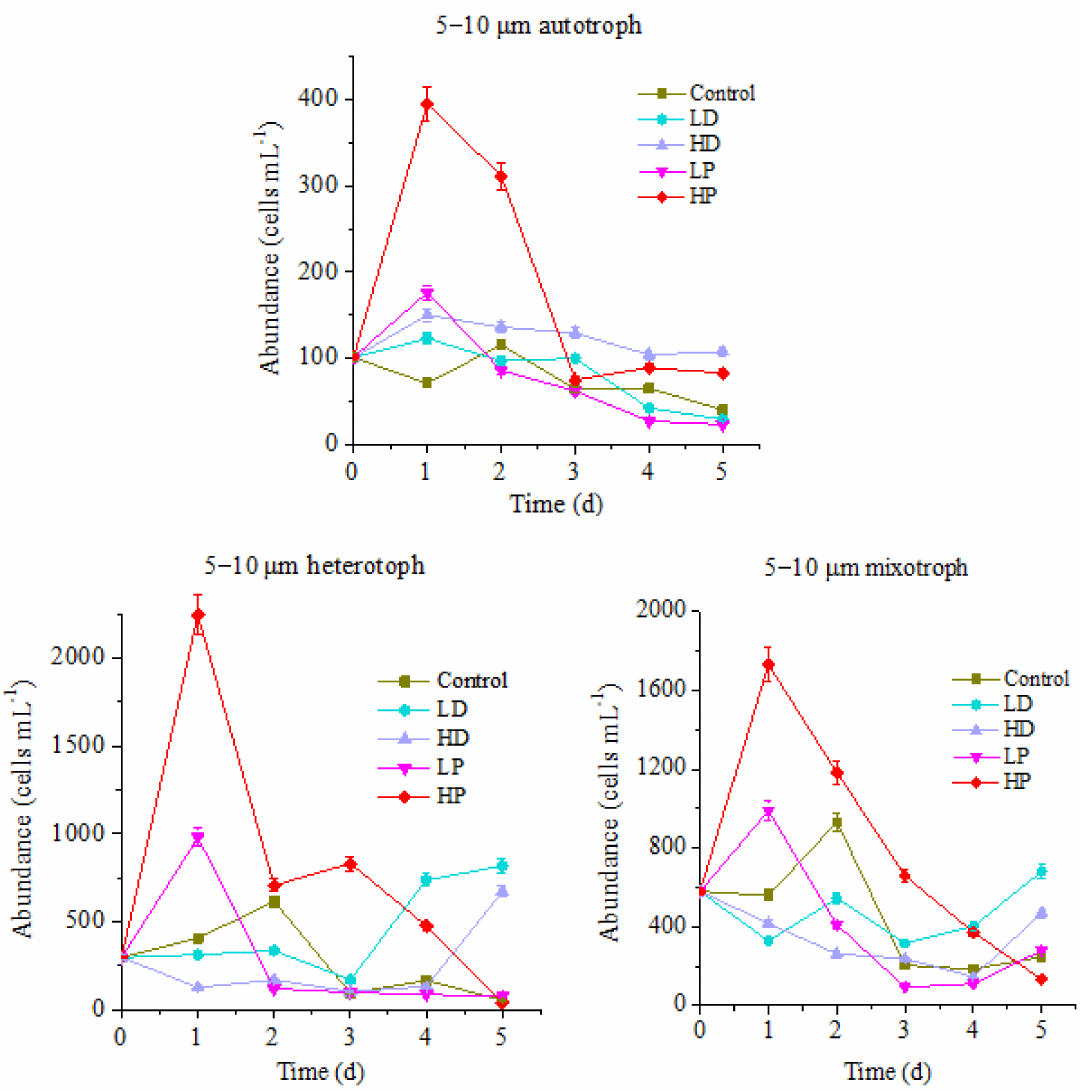
Figure 3. Variation of protists abundance in 5–10 µ m